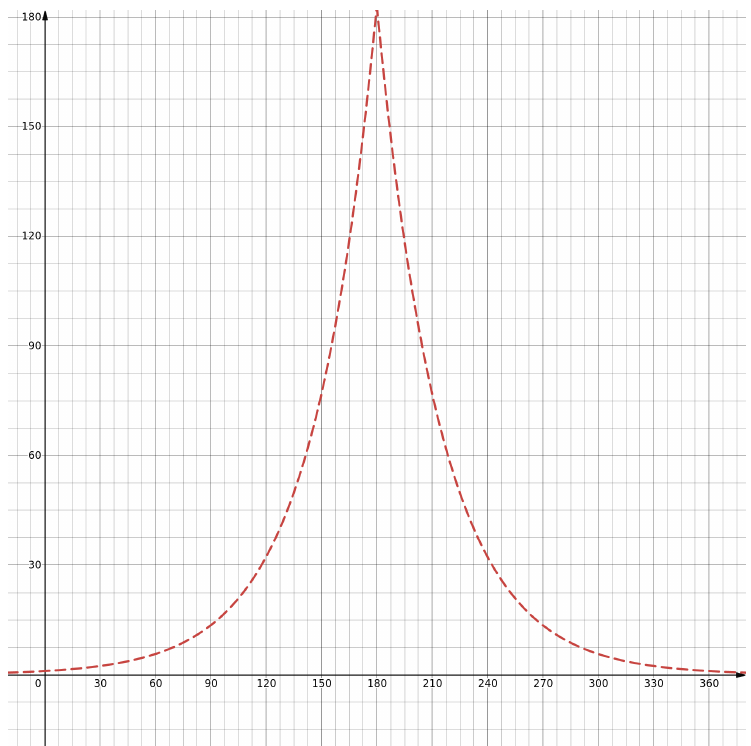
Figure 1. Vector values of 360